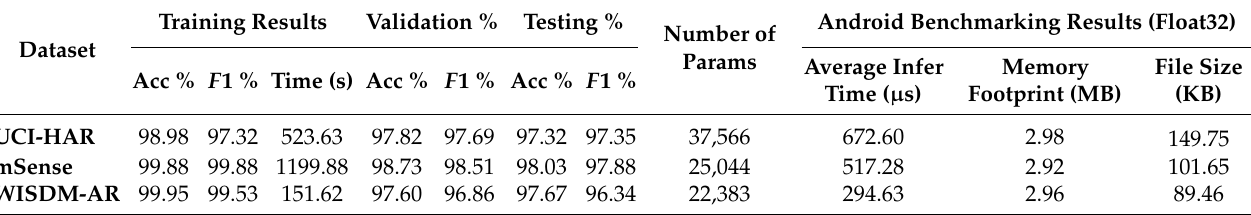
Table 3. Training, validation, and testing results of the MF CNN classifier on the UCI-HAR, Motion- Sense, and WISDM-AR